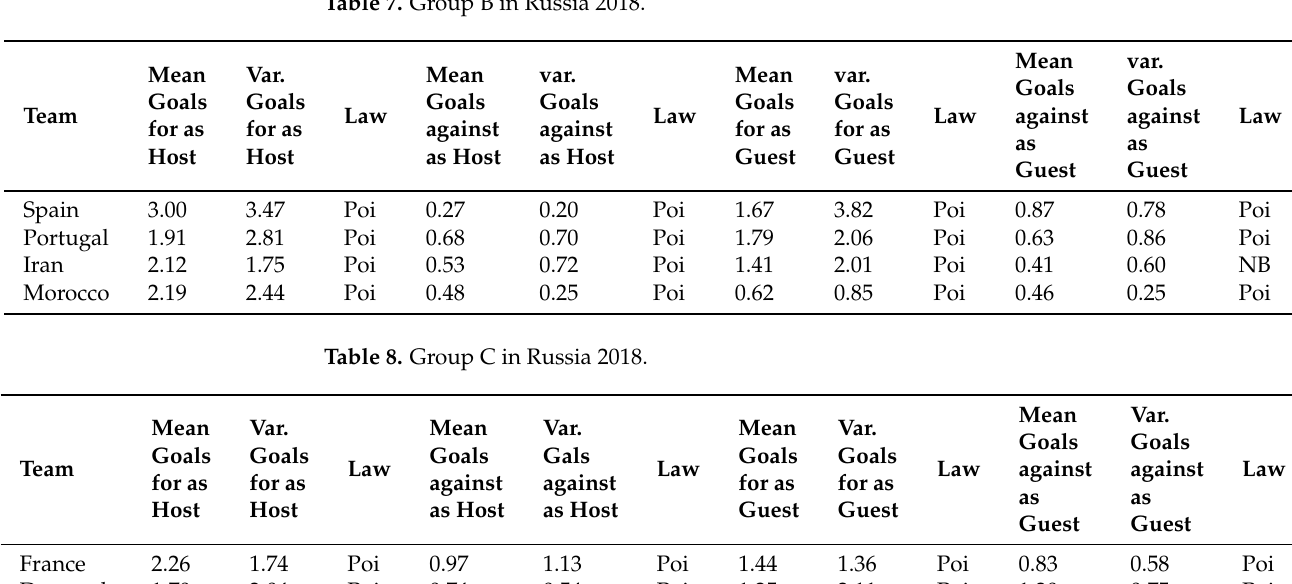
Table 7. Group B in Russia 2018.